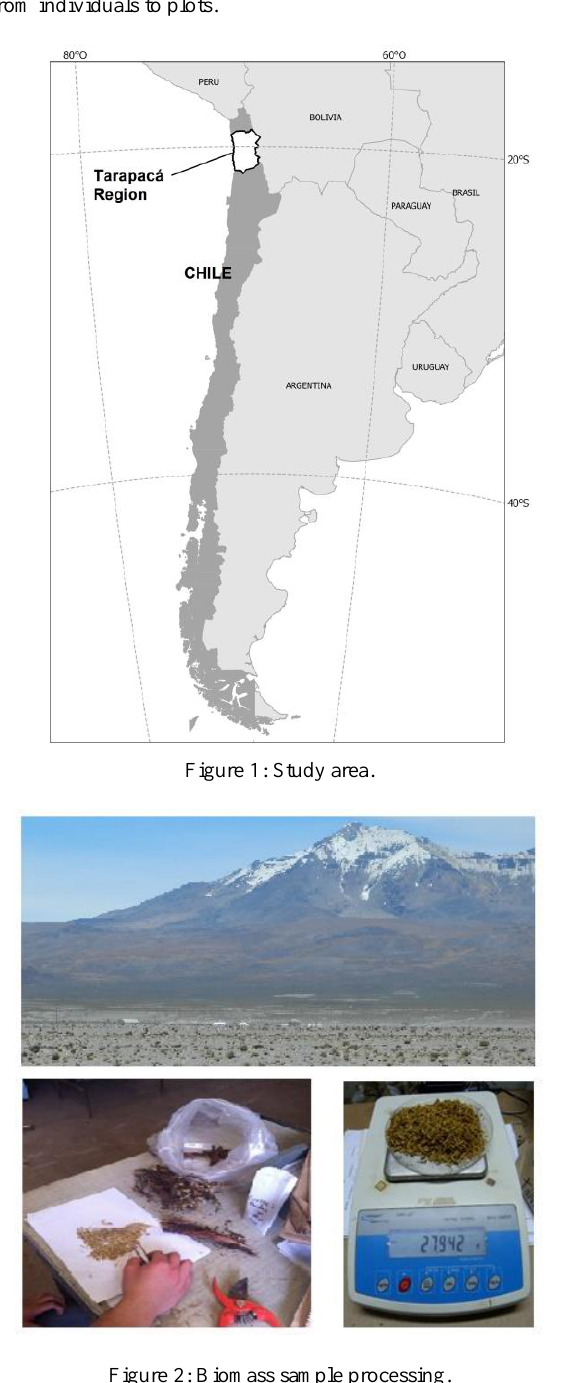
Figure 2: Biomass sample processing.